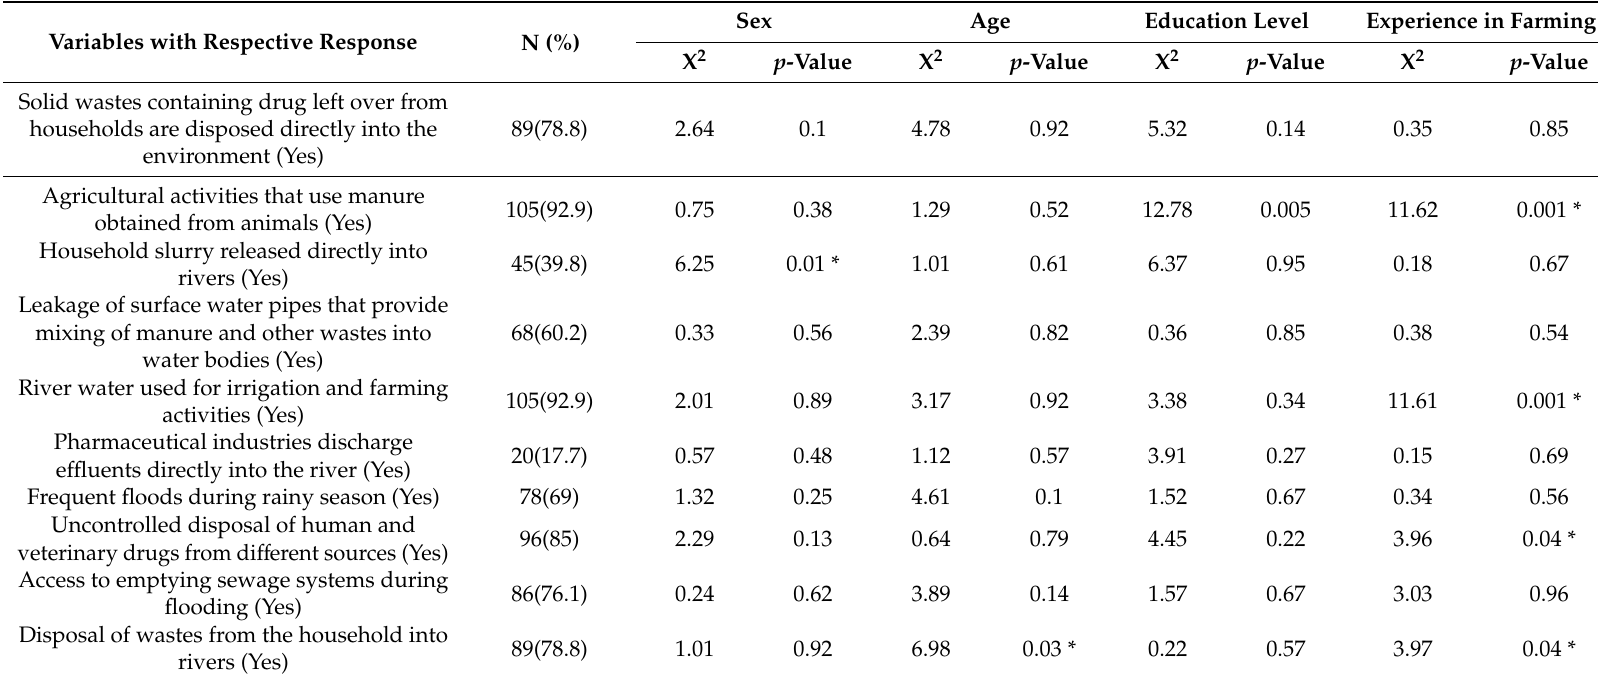
Table 6. Respondent’s perception of the factors associated with antimicrobial resistance spread in